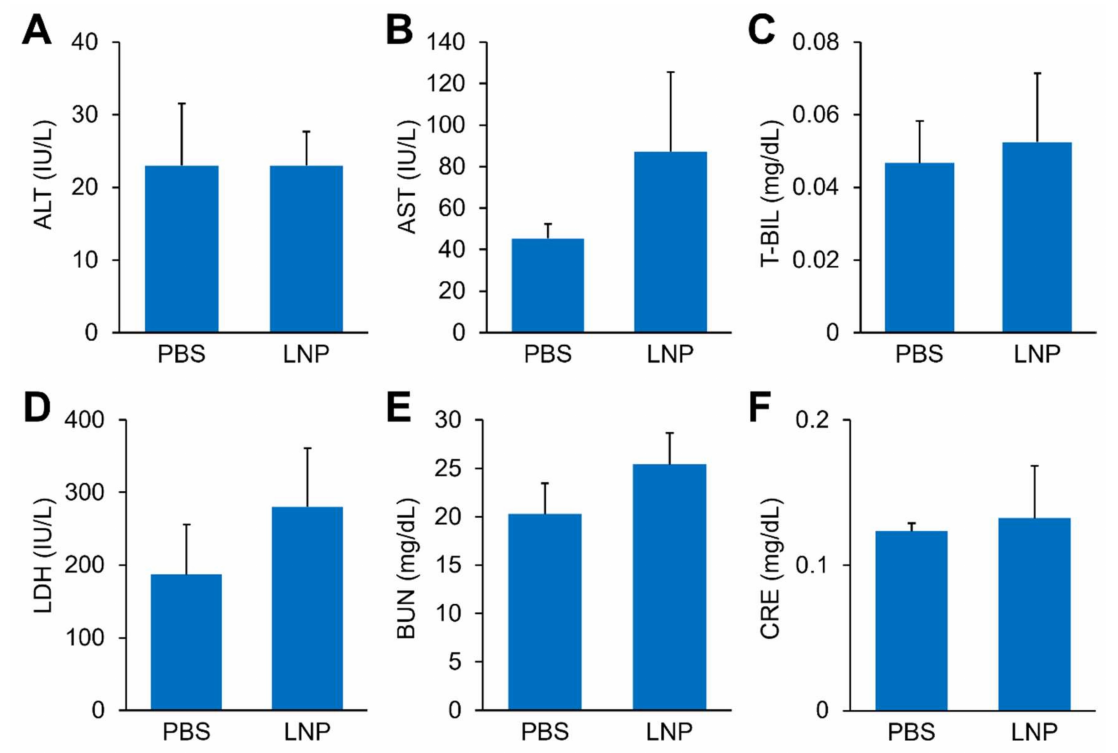
Figure 6. Safety of the A-11-LNPs. Serum chemistry parameters, ALT ( A ), AST ( B ), T-BIL ( C ), LDH ( D ), BUN ( E ), and CRE ( F ) were measured 24 h after the last injection of OVA mRNA-loaded A-11-LNPs at two doses of 0.03 mg mRNA/kg. n =